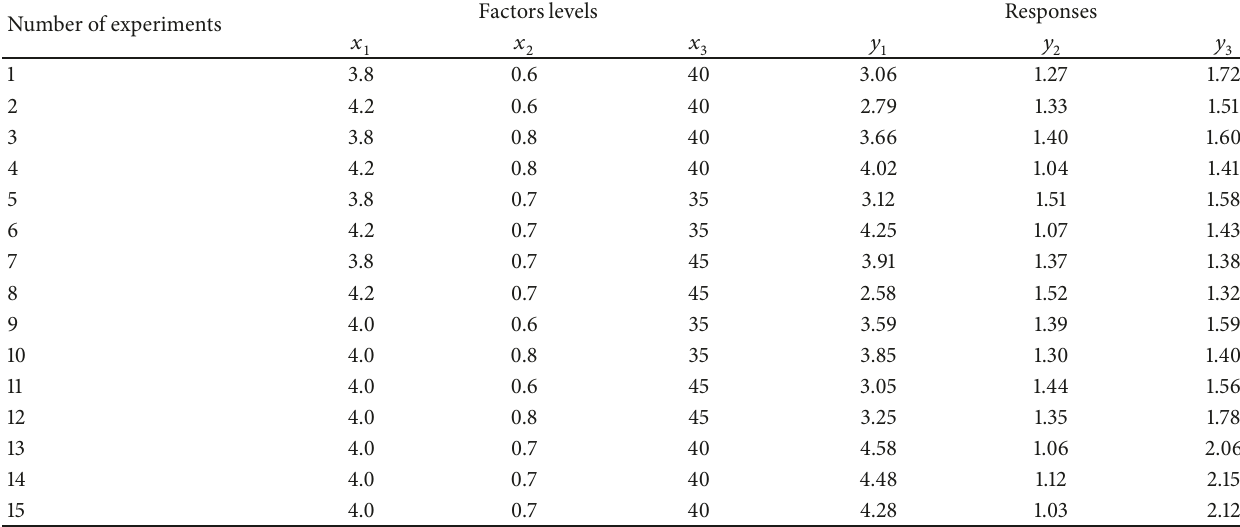
Table 2: Box-Behnken experimental design matrixes of the selected independent variables and studied responses. Factors Number of experiments